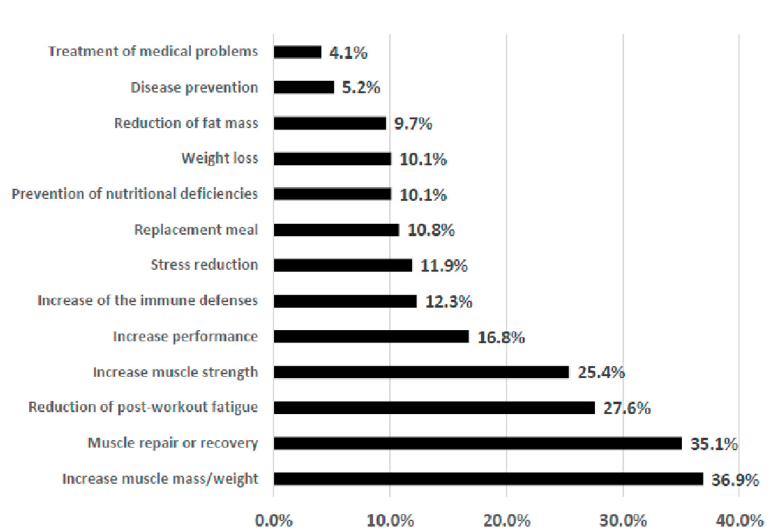
Figure 2. Reasons for supplement usage in the sub-sample that declared use ( n = 268).